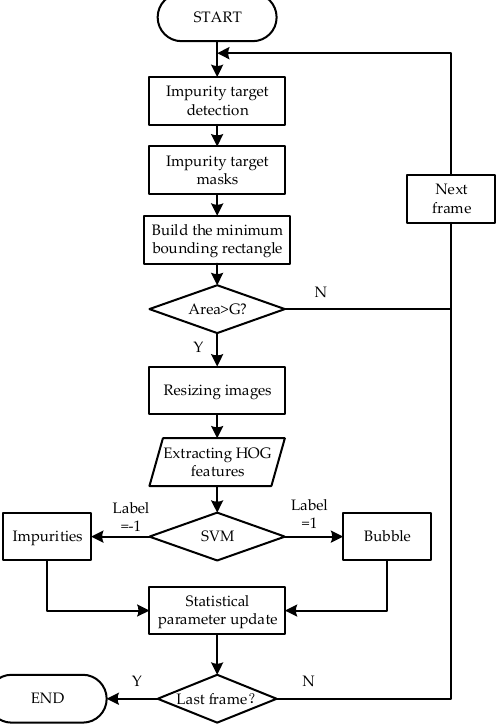
Figure 8. Flow diagram of HOG-SVM recognition algorithm.